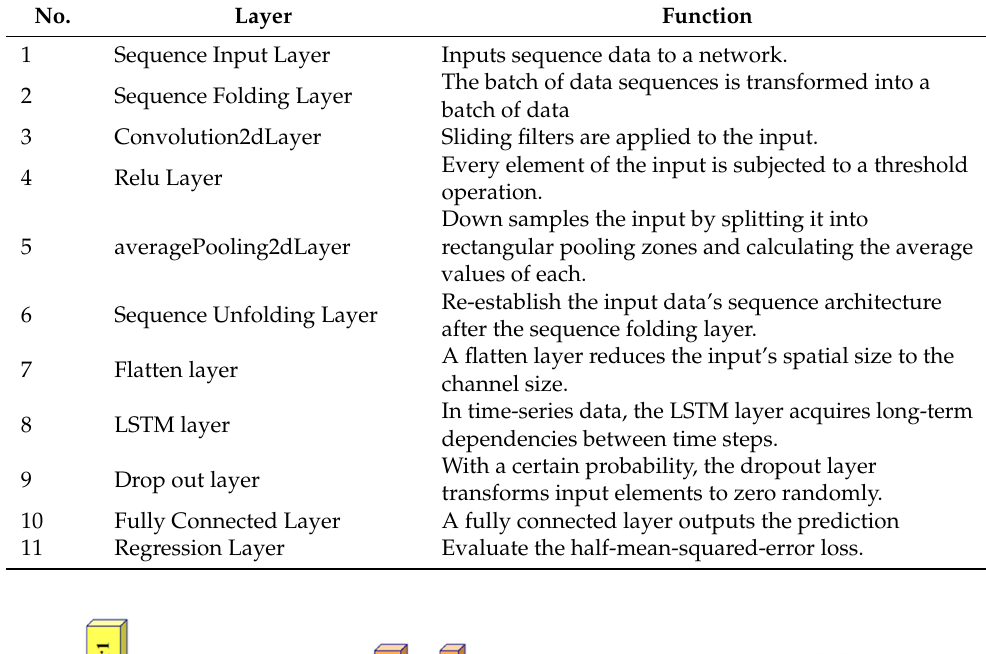
Table 2. Multi step-CNN stacked layers and their functions.